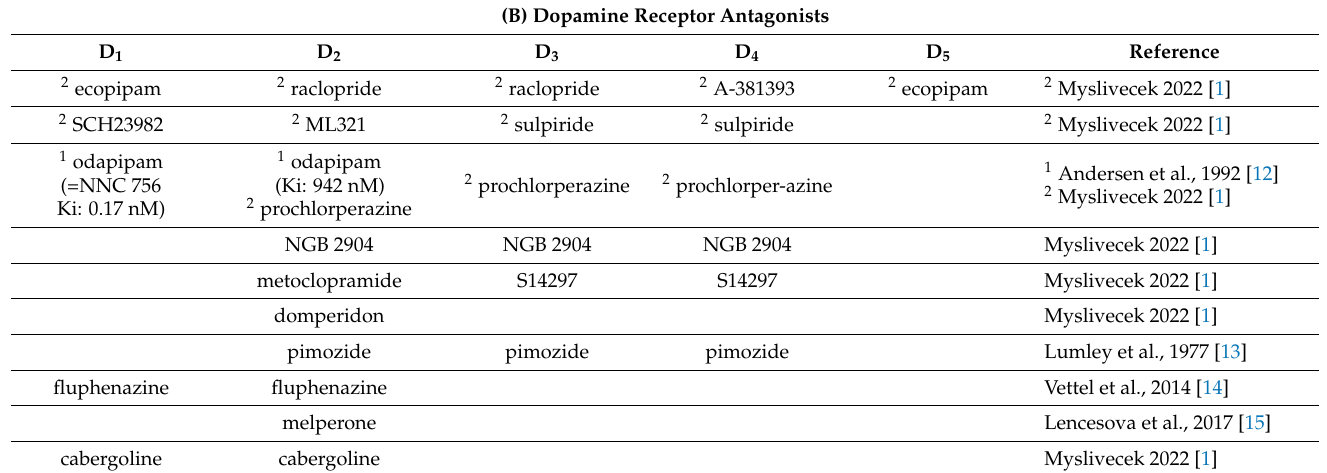
Table 1. Cont. (B) Dopamine Receptor